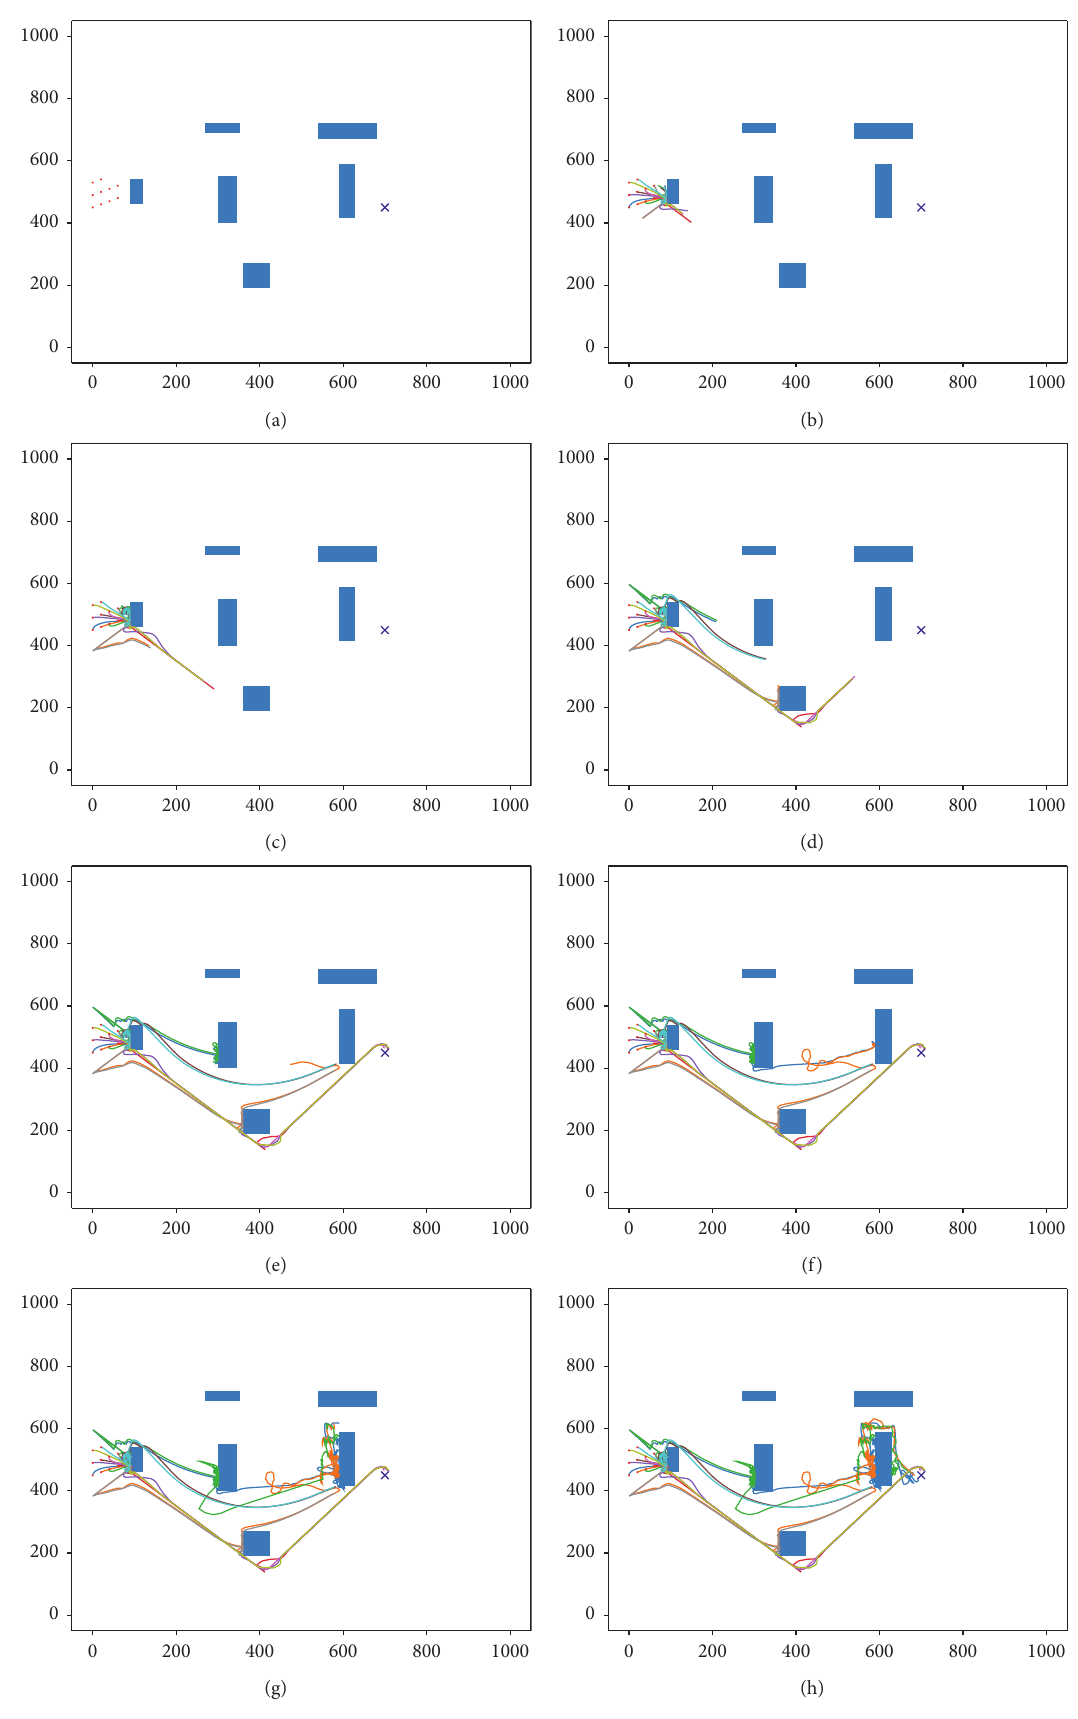
Figure 2: Single target search example of the proposed method. (a) t � 0. (b) t � 100. (c) t � 200. (d) t � 300. (e) t � 400. (f) t � 500. (g) t � 800. (h) t �